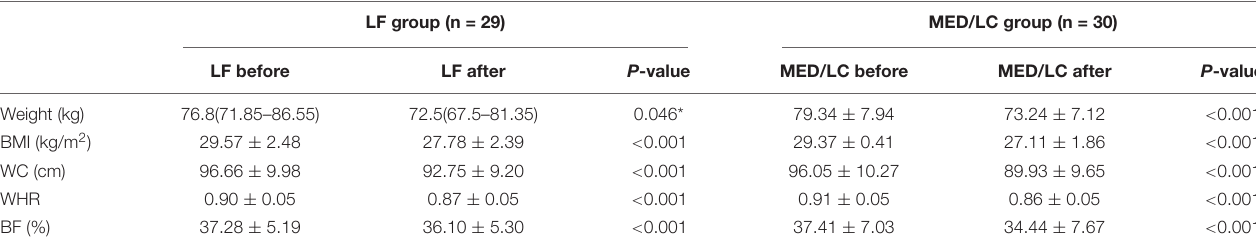
FIGURE 3 | Comparison of changes in anthropometric variables between two groups. (A) The MED/LC diet resulted in more weight loss than the LF diet. (B) MED/LC diet reduced body mass index (BMI) more than LF diet. (C) The MED/LC diet resulted in more waist circumference (WC) loss than the LF diet. (D) MED/LC diet reduced waist-to-hip ratio (WHR) more than LF diet. (E) The MED/LC diet resulted in more body fat percentage (BF%) loss than the LF diet. Data are mean ( ± SD). Analysis of variance with a covariance (ANCOVA) test was used. TABLE 3 | Anthropometric measurements and body composition at baseline and after the intervention. LF group (n =